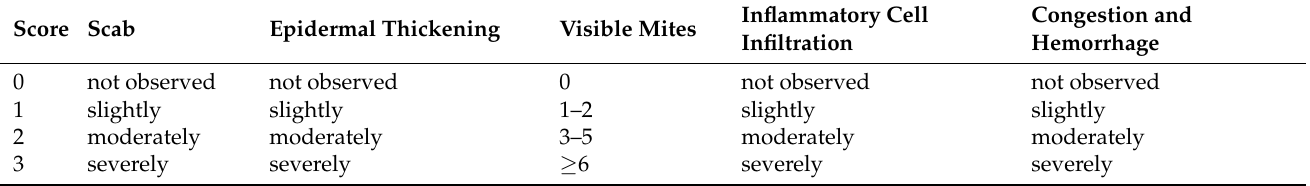
Table 1. Pathological damage scoring criteria for rabbit